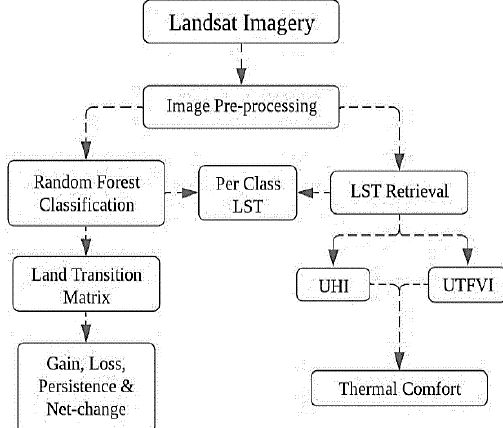
Figure 2: Flowchart of the